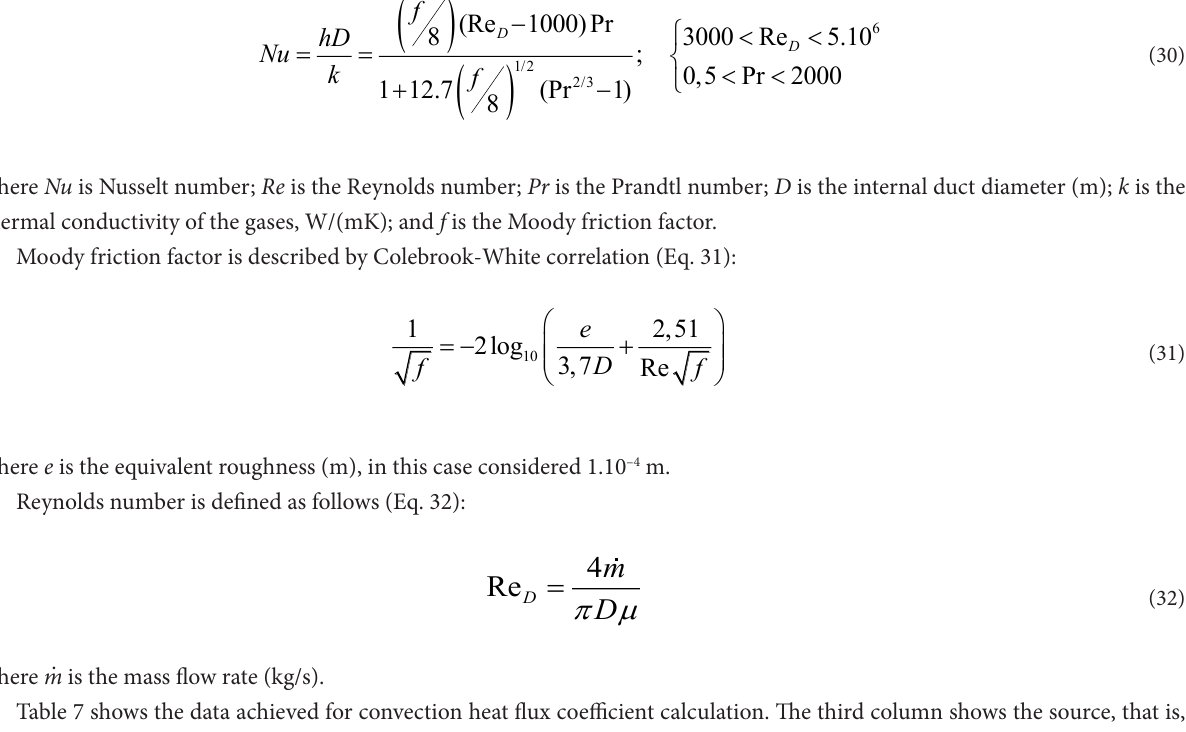
Table 7. Data for convection heat flux coefficient